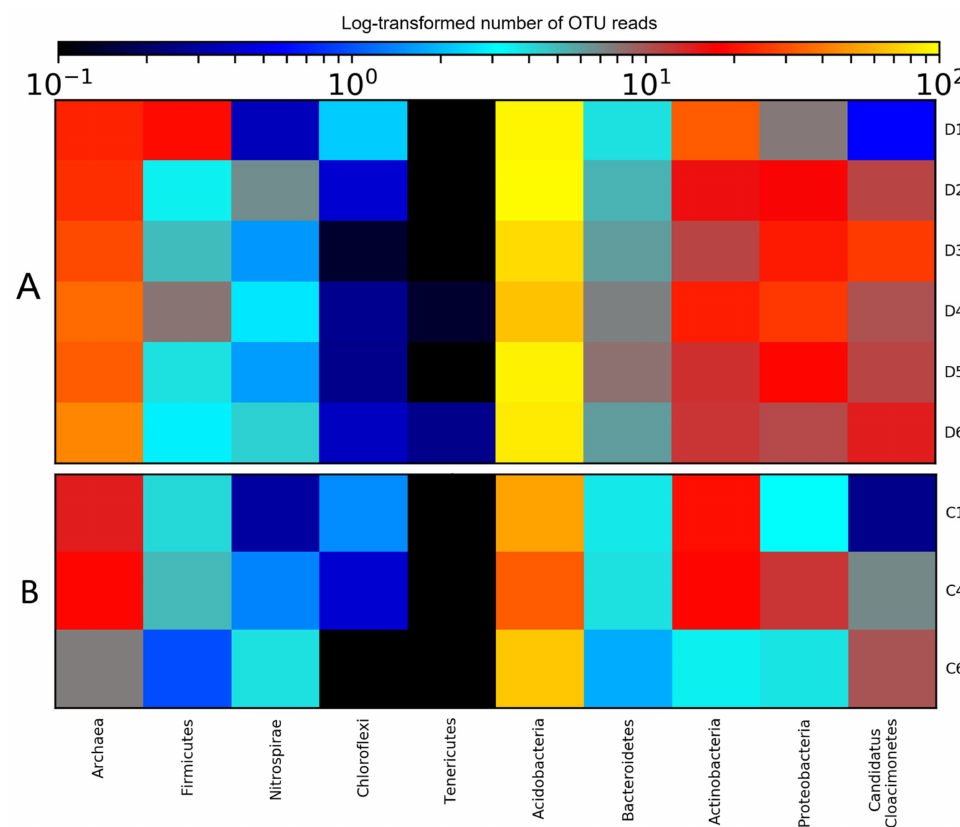
Figure 4. Heatmap with log-transformed number of OTU reads [ppm] at phylum level, presenting changes in microbial abundance in sewage sludge samples from process ( A ) and control bioreactors ( B ). The mean values noted in each experimental series used in the analysis. D—dose ID, C— control